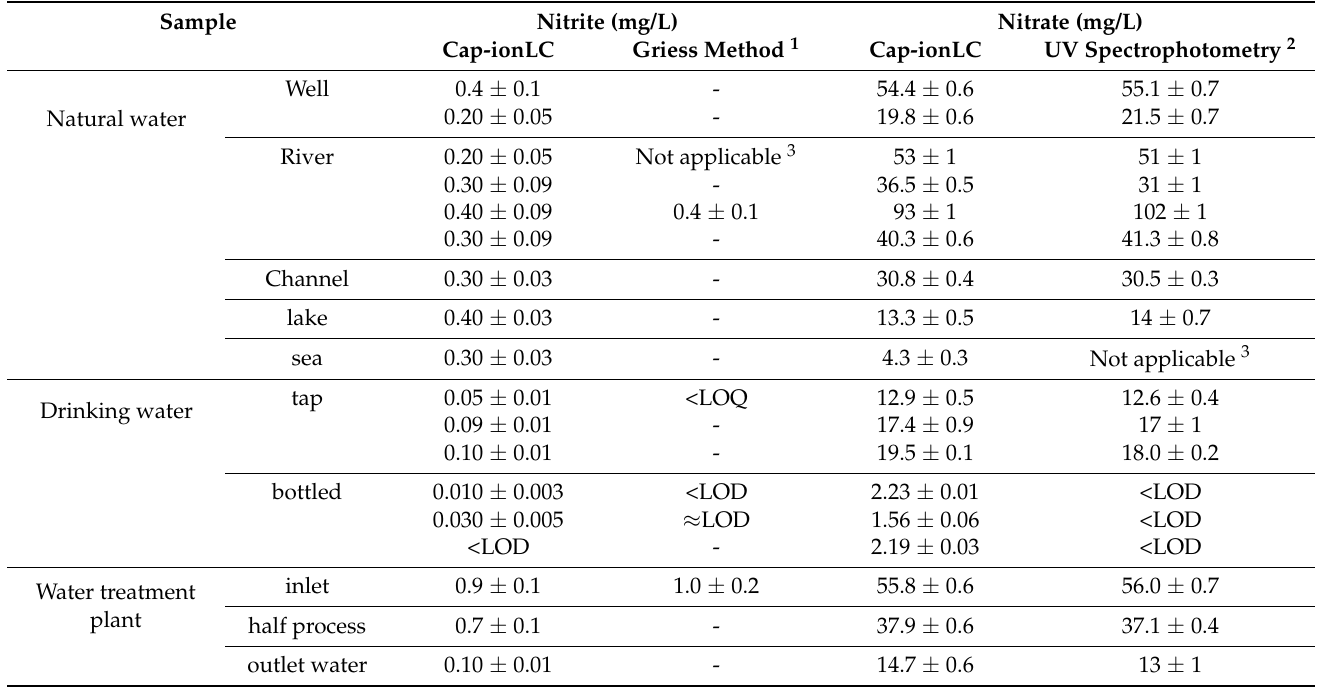
Table 4. Nitrite and nitrate concentration in real water samples (natural water, drinking water and water treatment plant) (n = 4). For more explanations see